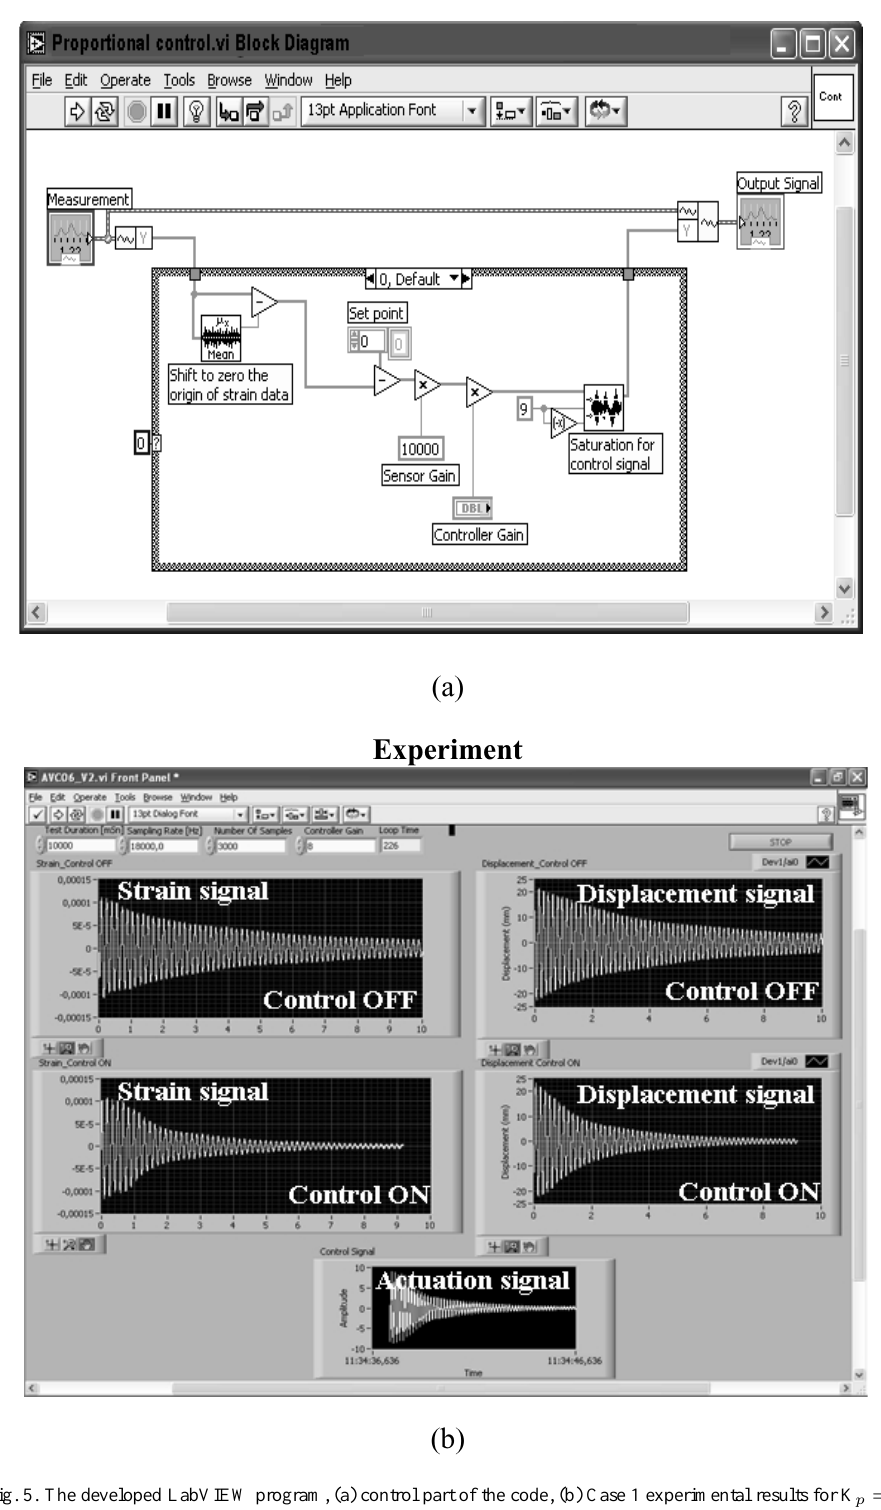
Fig. 5. The developed LabVIEW program, (a) control part of the code, (b) Case 1 experimental results for K p =